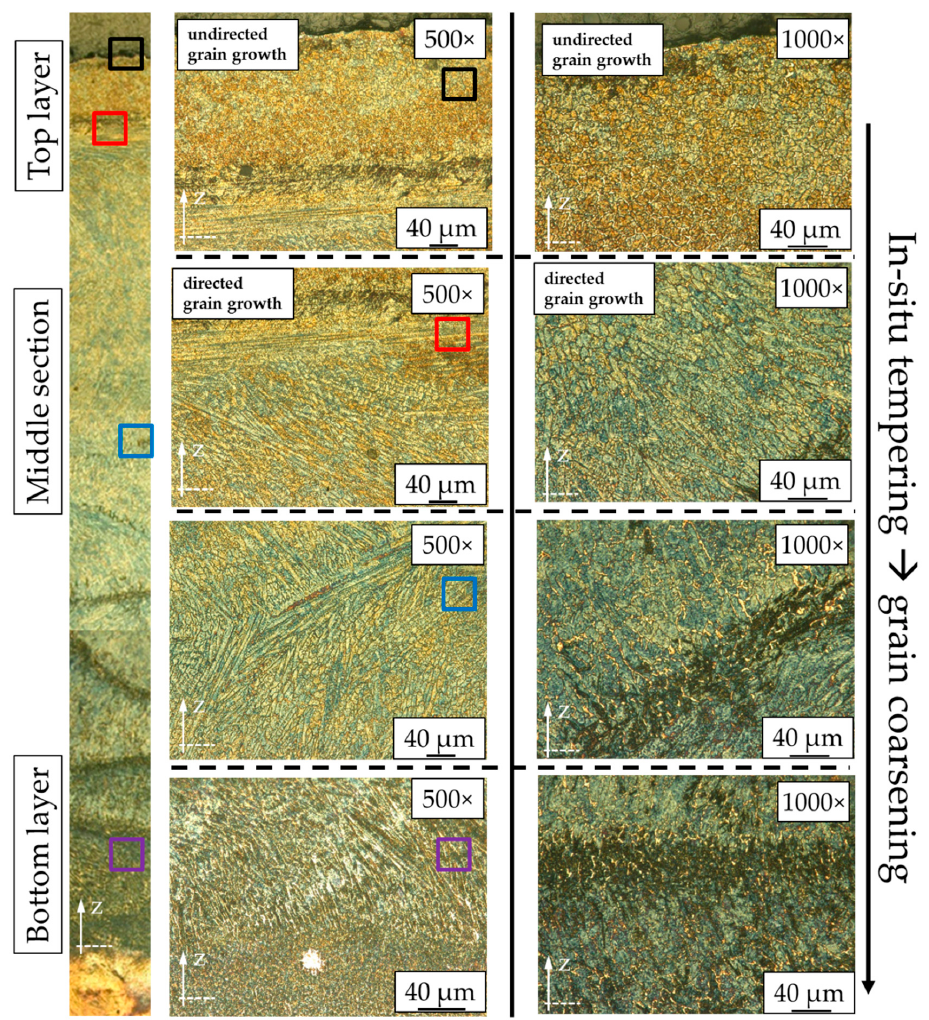
Figure 10. Microscope images of the local microstructure (top layer, middle section and bottom layer) of a ten-layered sample containing 0.2 wt. % carbon black nanoparticles (etching method Behara I; process parameters: P = 800 W , (cid:1865)(cid:4662) = 3.7 g/min , f rate = 400 mm/min).